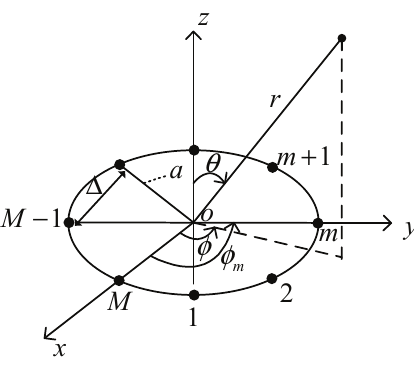
Figure 2. Structure of a Uniform Circular Array (UCA) antenna.